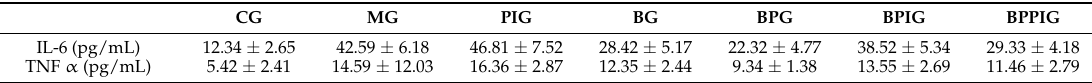
Table 5. The comparison of inflammatory cytokines among different groups.